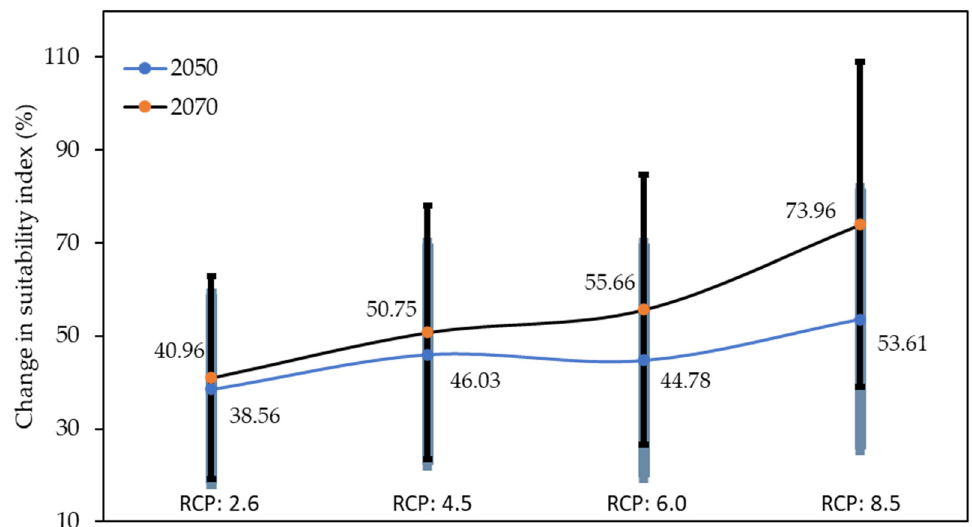
Figure 4. Average change (percent) of ASFV suitability index and standard deviation (error bars) in different scenarios from current year to 2050 and 2070.